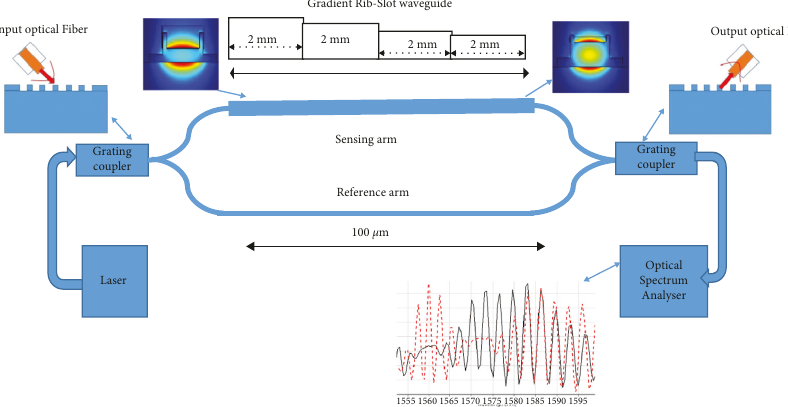
Figure 1: Silicon nitride biosensor setup with MZI and a grating